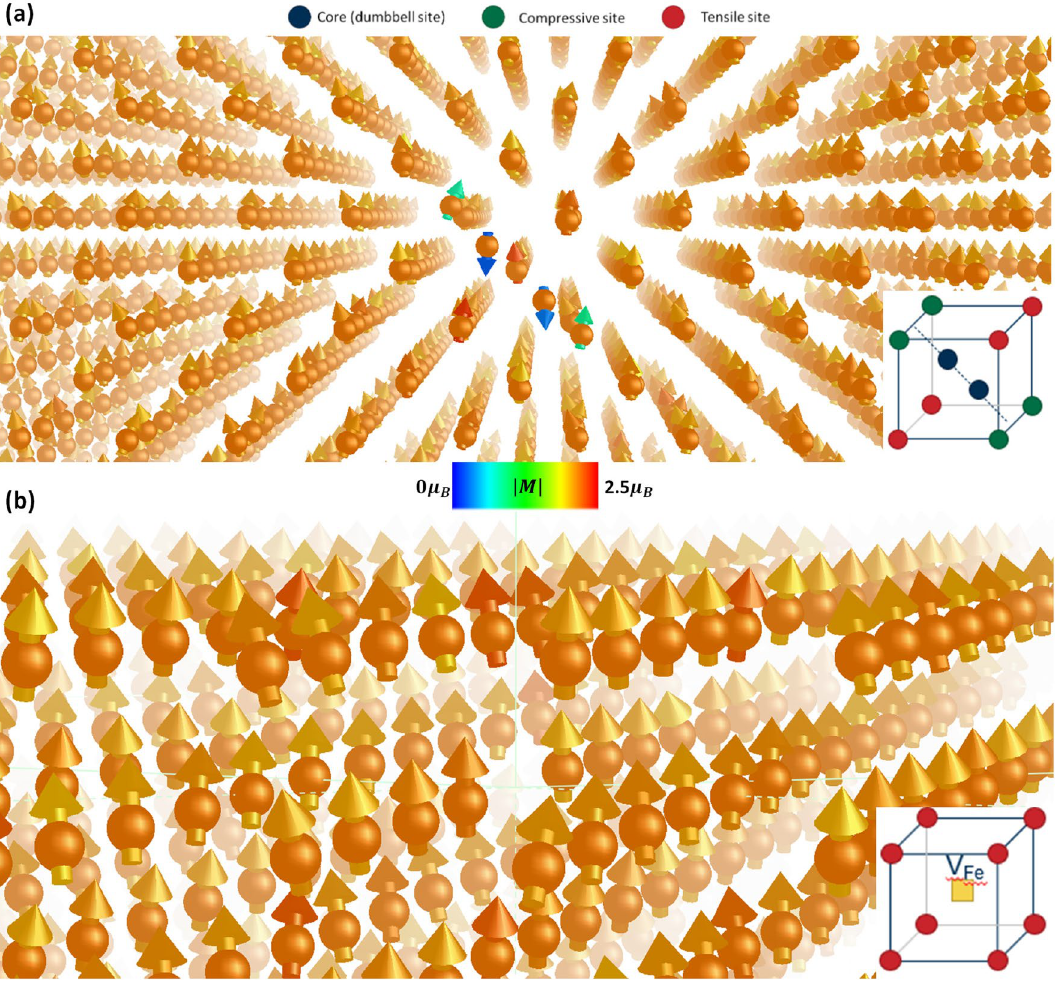
110 Figure 2. A snapshot of ( a ) a dumbbell self-interstitial atom configuration and ( b ) a mono-vacancy in (cid:31) (cid:30) iron at 10 K. Magnitudes of magnetic moments are indicated according to the colour bar. The insets shows the schematic configurations. For the SIA, the schematic indicates the core (blue), compressive (green) and tensile (red)